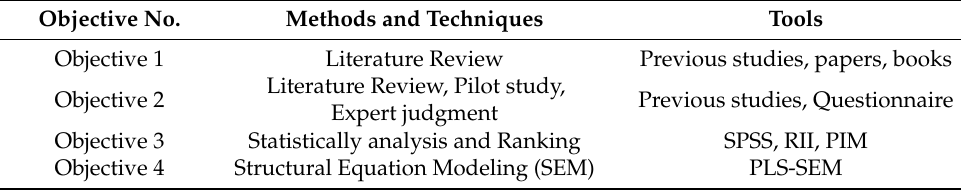
Table 4. The methods, techniques, and tools used in research.